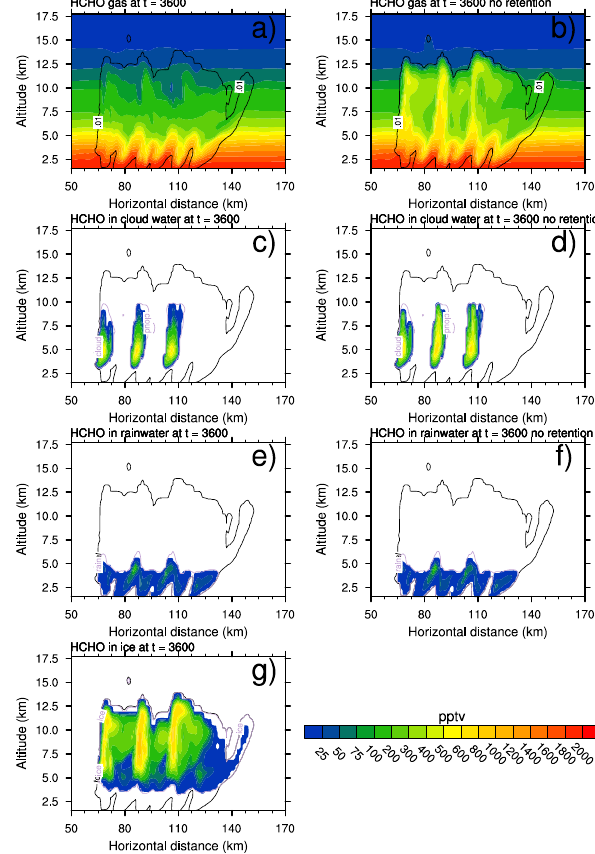
Figure 12. STERAO case: results at t = 3600 s for vertical cross section of HCHO mixing 2 Fig. 12. STERAO case – results at t = 3600s for vertical cross sec- ratio in pptv along the segment indicated on Fig. 10a, at the left hand side for simulation with 3 tion of HCHO mixing ratio inpptv along the segment indicated in Fig. 10a, left hand side, for simulation with retention in ice, and retention in ice and at the right hand side for simulation without retention: (a) and (b) in gas 4 right hand side for simulation without retention: (a) and (b) in gas phase, (c) and (d) in cloud water, (e) and (f) in rainwater, (g) in precipitating ice. The black 5 phase, (c) and (d) in cloud water, (e) and (f) in rainwater, and (g) line represents the total hydrometeors mixing ratio equal to 0.01 g/kg, the mauve line on (c) 6 in precipitating ice. The black line represents the total hydromete- ors mixing ratio equal to 0.01gkg − 1 , the grey line in (c) and (d) is the same for cloud water, the grey line in (e) and (f) is the same for rainwater, and the grey line in (g) is the same for precipitating